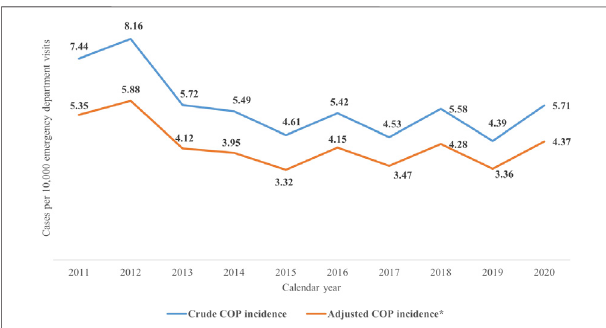
FIGURE 2 | The crude and adjusted incidence of COP during 2011 – 2020. COP, carbon monoxide poisoning. *The crude incidence of COP multiplied by the PPV (2011 – 2015: 72%; 2016 – 2020: 76.6%) equals to the adjusted incidence of